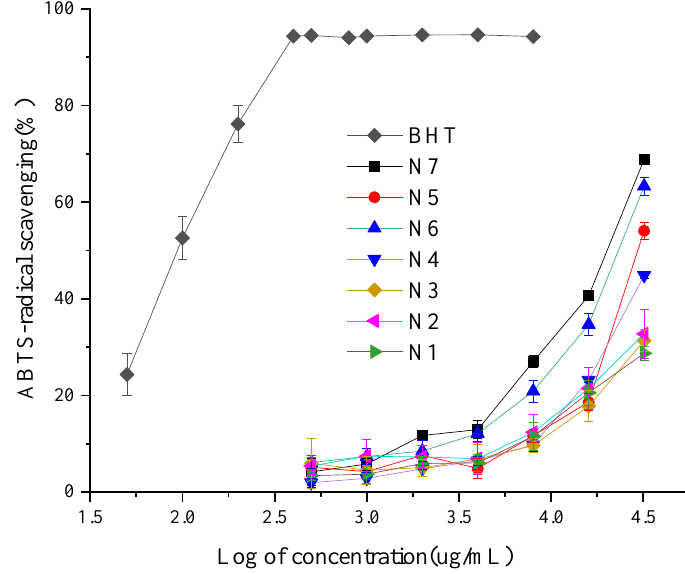
Figure 3. ABTS-radical scavenging activities of the BHT and EOCC.